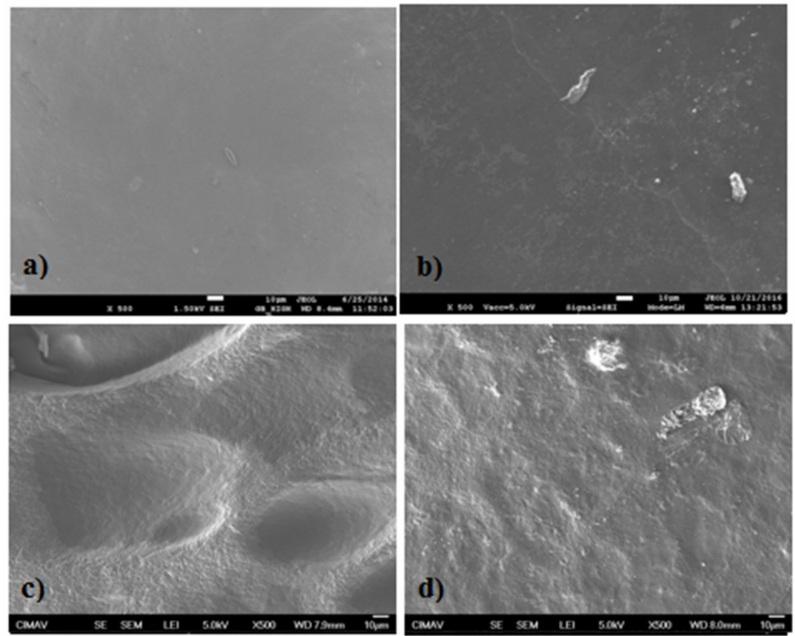
Figure 8. Scanning electronic micrograph (SEM) of ( a ) QS2; ( b ) QSA5; ( c ) QSAm5; and ( d ) QSB5 at 500 × .